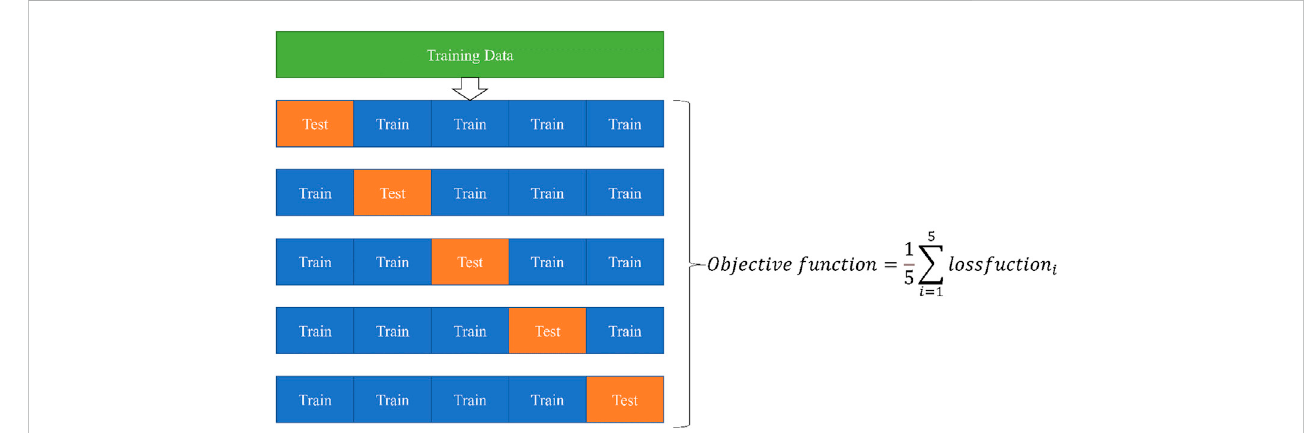
FIGURE 6 Five-fold cross-validation.